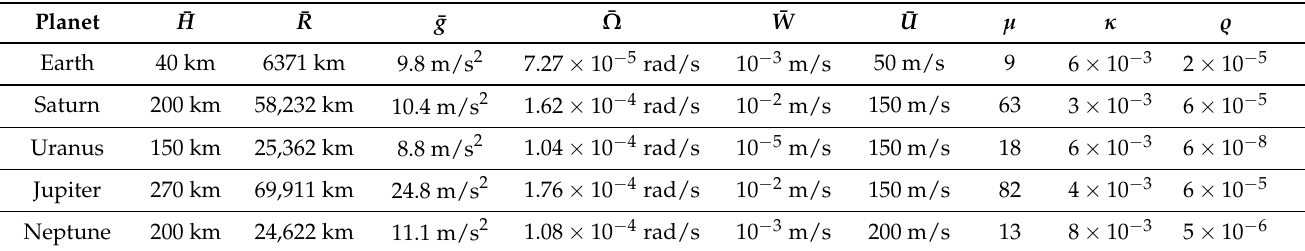
Table 1. Reference values of parameters corresponding to some